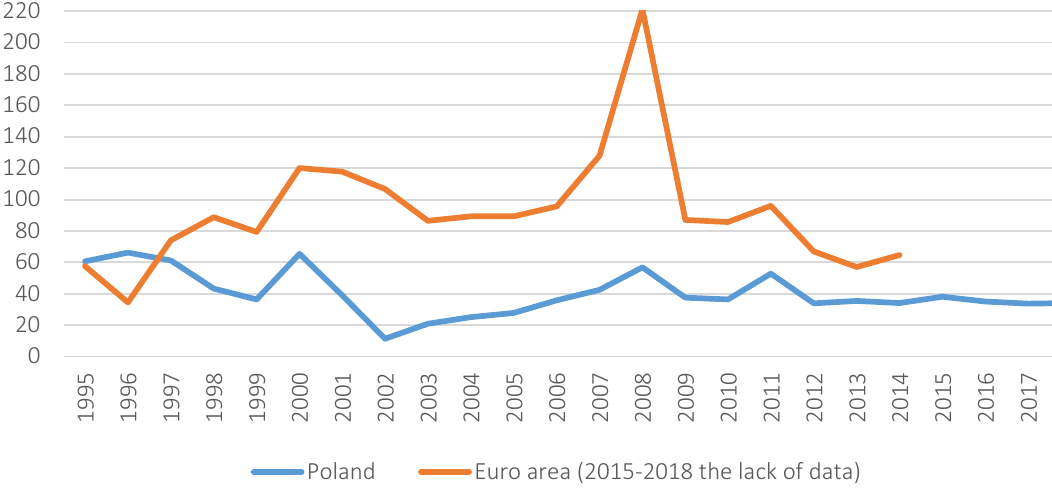
Figure 4. Turnover ratio of domestic shares (%) in 1995–2018